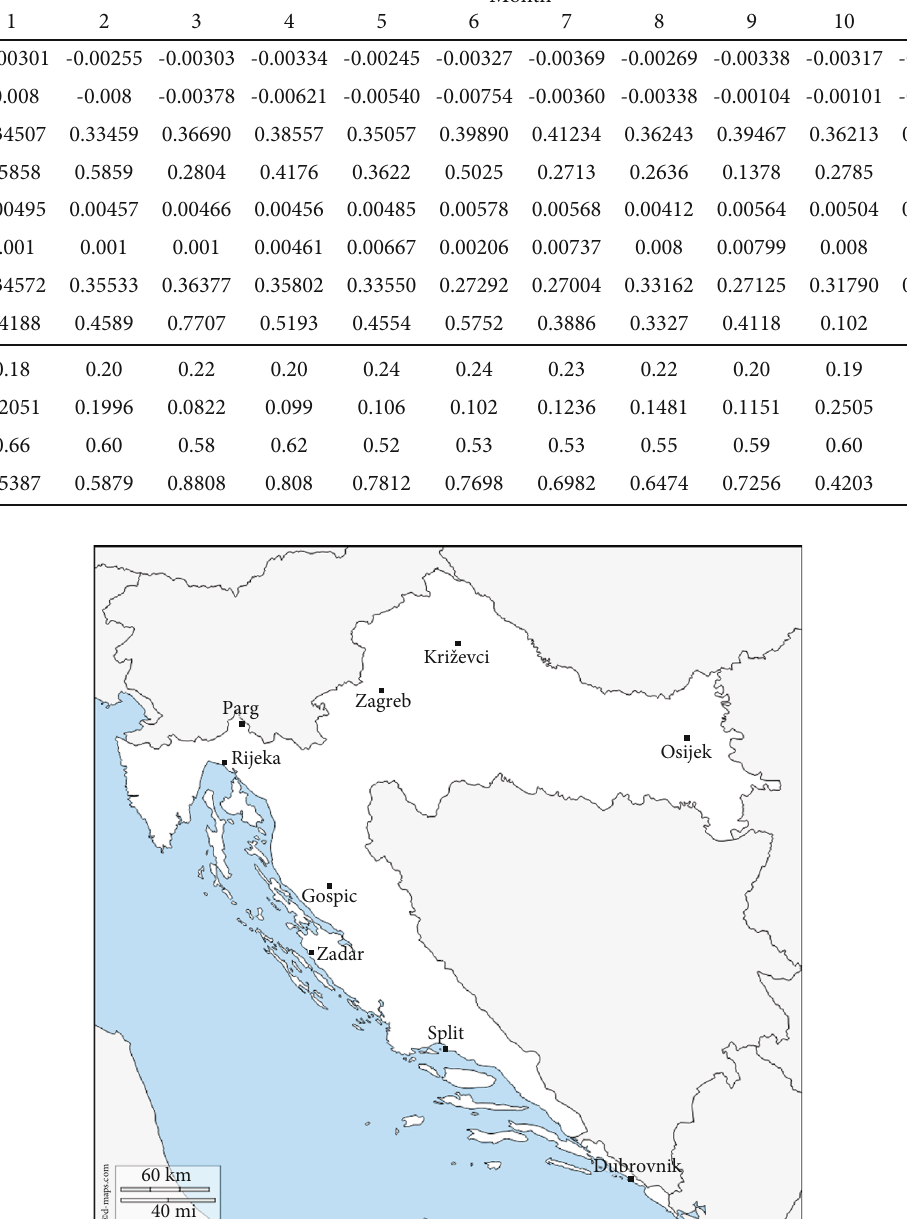
Table 1: The original and adjusted coe ffi cients (marked with apostrophe) for Dogniaux-Lemoine (Model 16) and Soler (Model 17) models. Model Coe ff